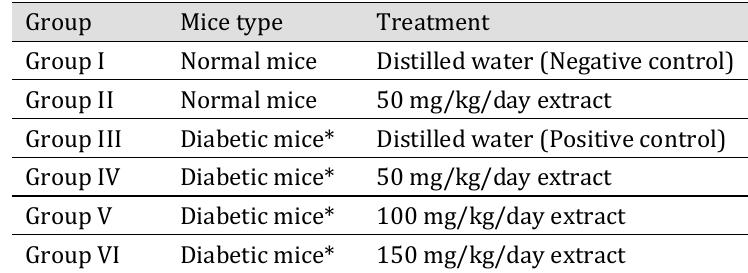
Table 1. The different group s o f mice used i n the experiment with